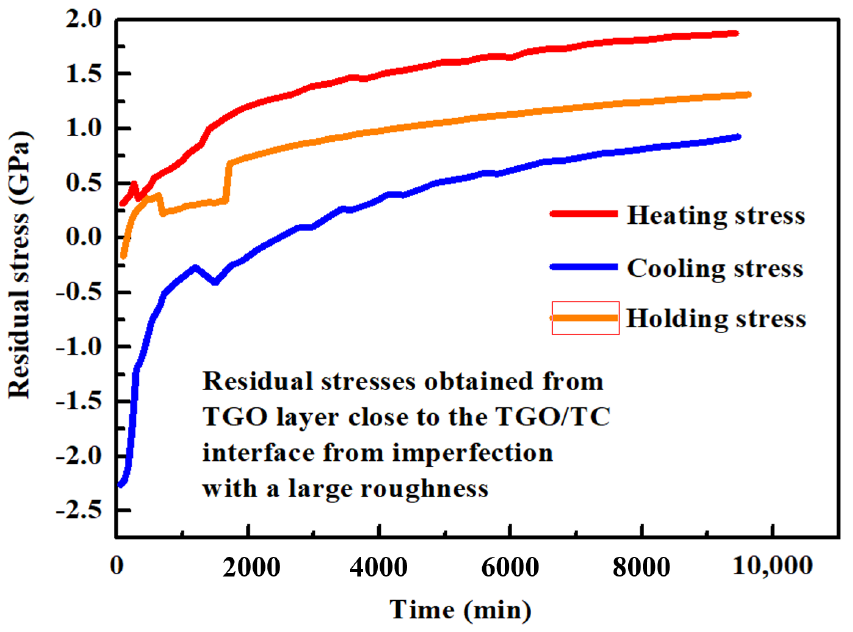
Figure 41. The maximum residual stress calculated within the TGO close to the TC/TGO interface.